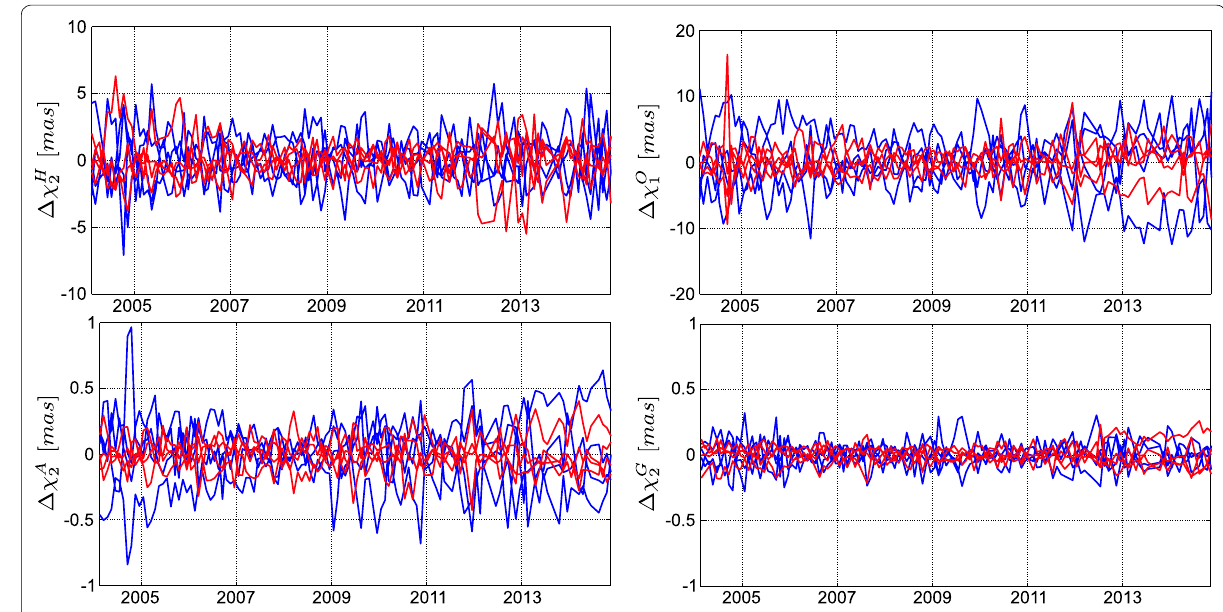
Fig. 8 Differences of the excitation functions for the mass effects of the continental hydrosphere χ H , the oceans χ O , Antarctica χ A and Greenland χ G derived from GRACE RL05 (blue) and RL06 (red) data with respect to the mean excitation functions